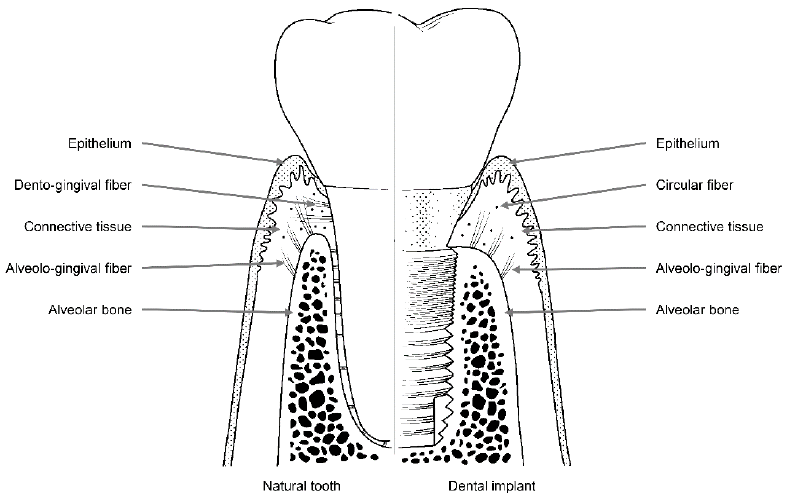
Figure 2. Soft and hard tissues with collagen fibers surrounding a natural tooth ( left ) and a dental implant ( right ).